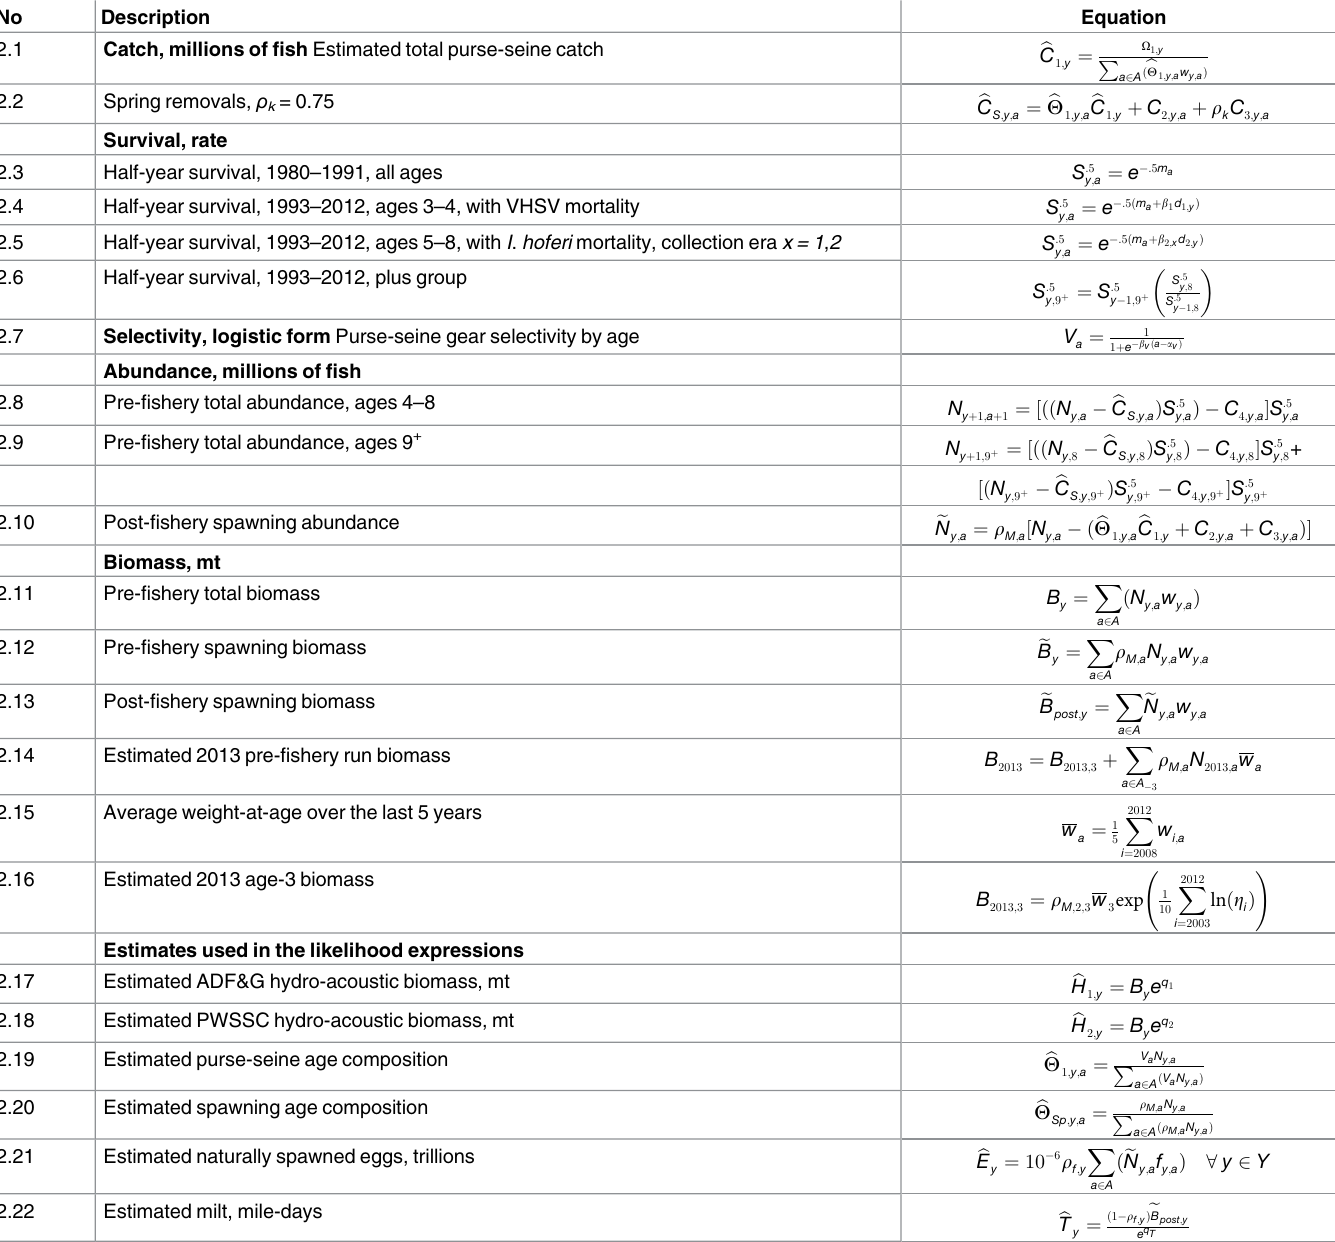
Table 2. Model formulation, first column gives the equation number, the second column gives a description, and the final column gives the mathe- matical form of the